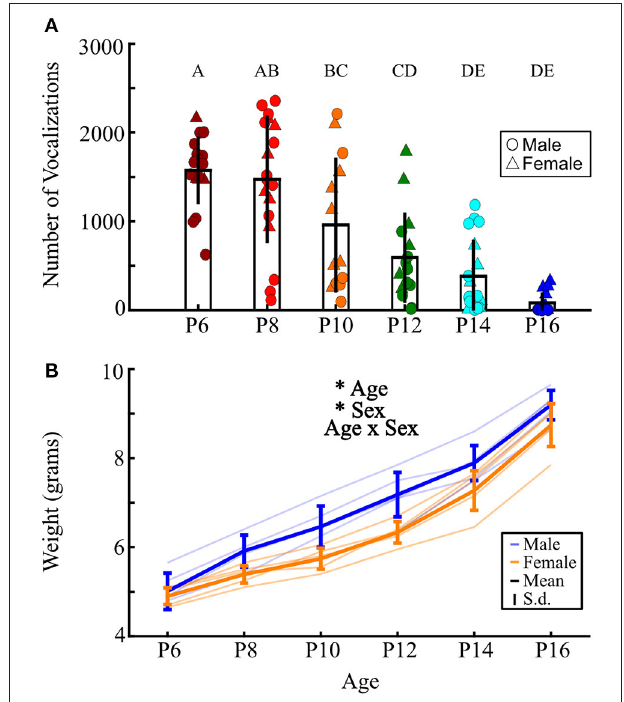
FIGURE 4 | Older pups emit fewer isolation-induced vocalizations than young pups. (A) Each point represents the total number of vocalizations emitted by a single pup across 10min of isolation; males are circles, females are triangles. Data presented as mean ± 1 standard deviation. n = 19, 19, 14, 16, 19, and 14 for P6, 8, 10, 12, 14, and 16, respectively. There was no main effect of sex (two-way ANOVA, age-by-sex), so male and female data were collapsed. Ages sharing a letter do not significantly differ from each other ( p ≥ 0.05, Tukey’s HSD post-hoc correction), while all other comparisons are significantly different ( p < 0.05). (B) Weights of pups across development. Each thin line represents an individual pup recorded over time. Thick blue lines show mean ± 1s.d. for males, orange show females. Two-way ANOVA found a main effect of age and sex (all p ≤ 10 − 3 ), with no significant interaction. * p <